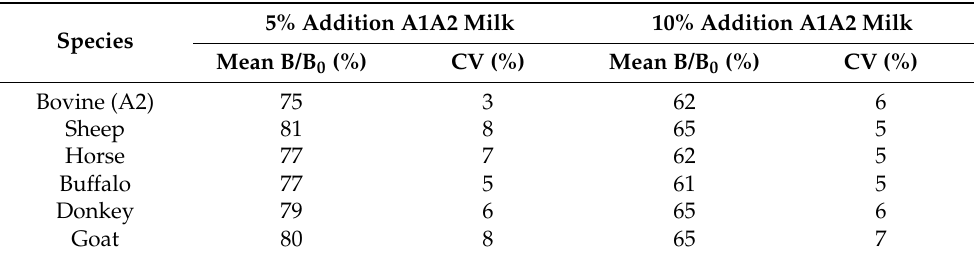
Table 1. Inter-assay repeatability for the β CA1 assay in the cMIA. Samples were Measured in Duplicate over 3 different days ( n = 6) with ddditions of 5- and 10% common raw bovine milk.